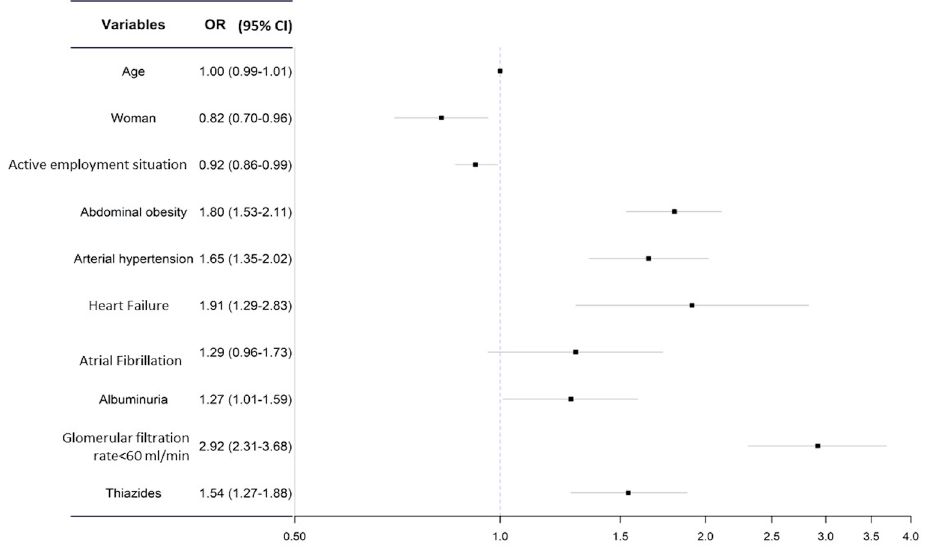
Figure 1. Multivariate analysis for the risk of hyperuricemia.